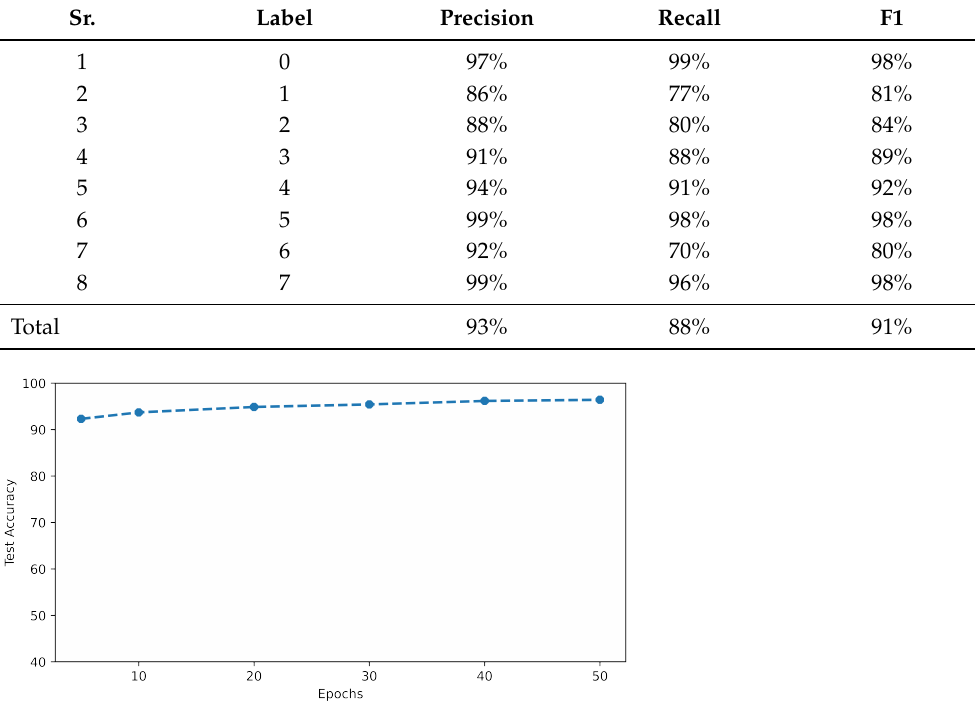
Figure 11. MLP test accuracy relationship with training for different numbers of